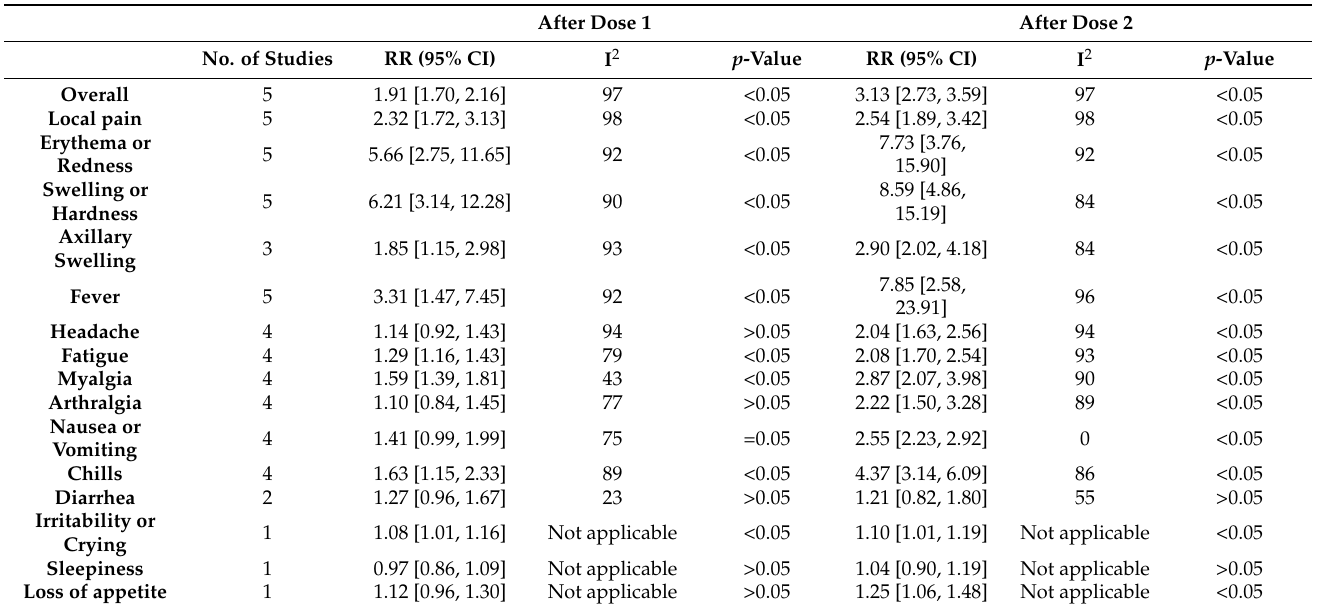
Table 4. Specific adverse reactions in the mRNA vaccine group versus the control group after dose 1 and dose 2. After Dose 1